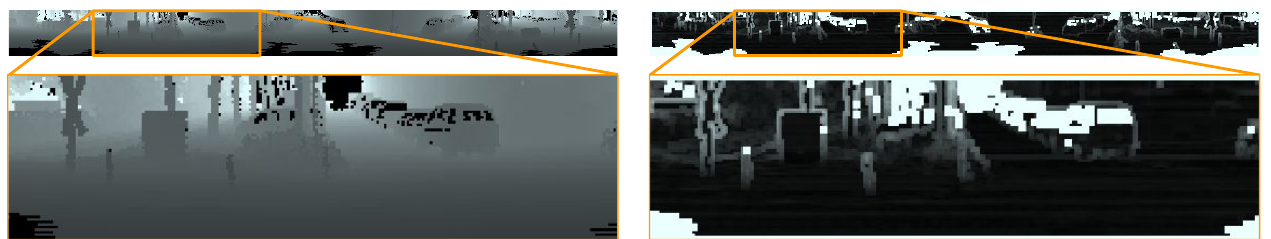
Figure 3. Flatness image ( right ) generated from S 0 ( left ) applying the LSF method. Flat surfaces such as the ground and walls appear darker, while non-planar pixels are displayed brighter. Images below are zoomed in areas of the panoramic images